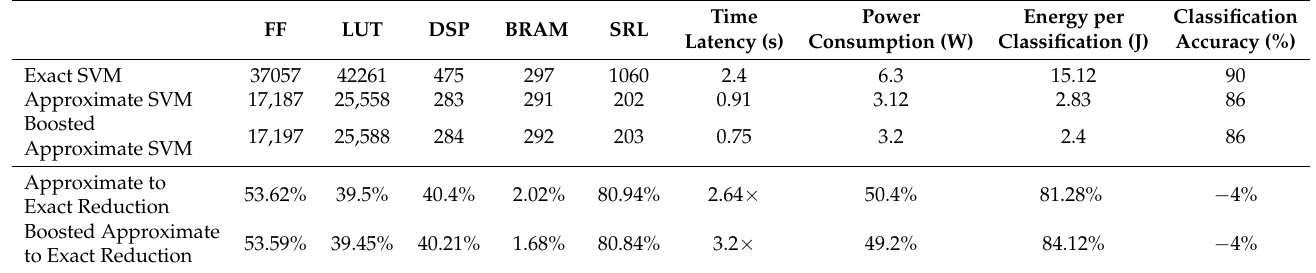
Table 2. FPGA performance profile of Exact and Approximate